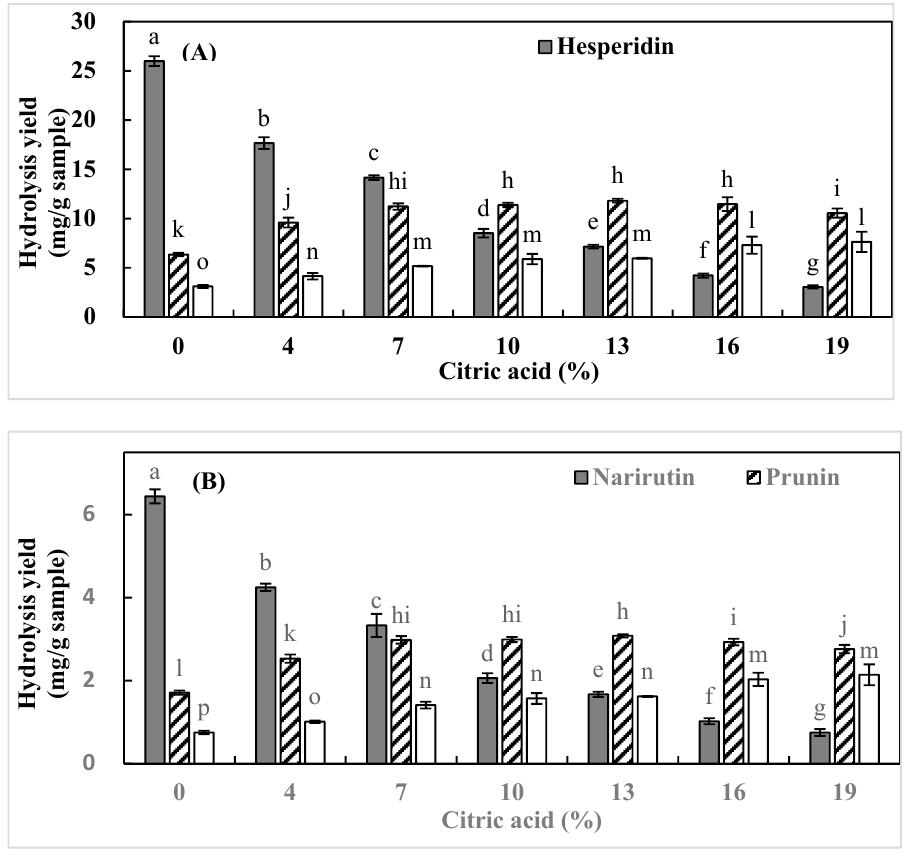
Figure 1. Hydrolysis yields of ( A ) hesperetin-7- O -glucoside and hesperetin and ( B ) prunin and naringenin obtained from immature Citrus unshiu pomace under different citric acid concentrations, a temperature of 120 °C, and a hydrolysis duration of 8 h. Bars accompanied by different letters (a–o) indicate significant differences ( n = 3) ( p < 0.05, Duncan’s test).